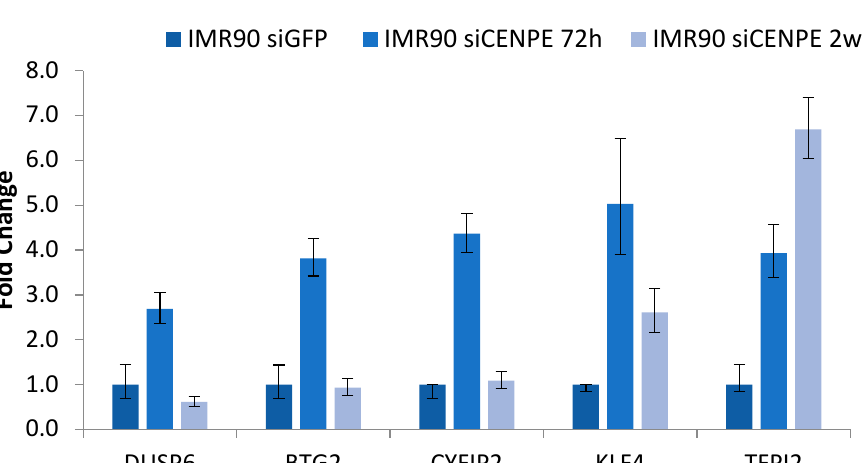
Figure 2. Relative mRNA expression levels of specific downregulated genes. RT-qPCR results from siCENP-E 72 h and siCENP-E 2 w RNA-interfered IMR90 cells compared to siGFP-transfected cells. The analysis were performed in triplicate. The data presented are the means ± SD (error bar) of fold changes. Table 2. Gene sets enriched in CENP-E transient knocked-down IMR90 cells.